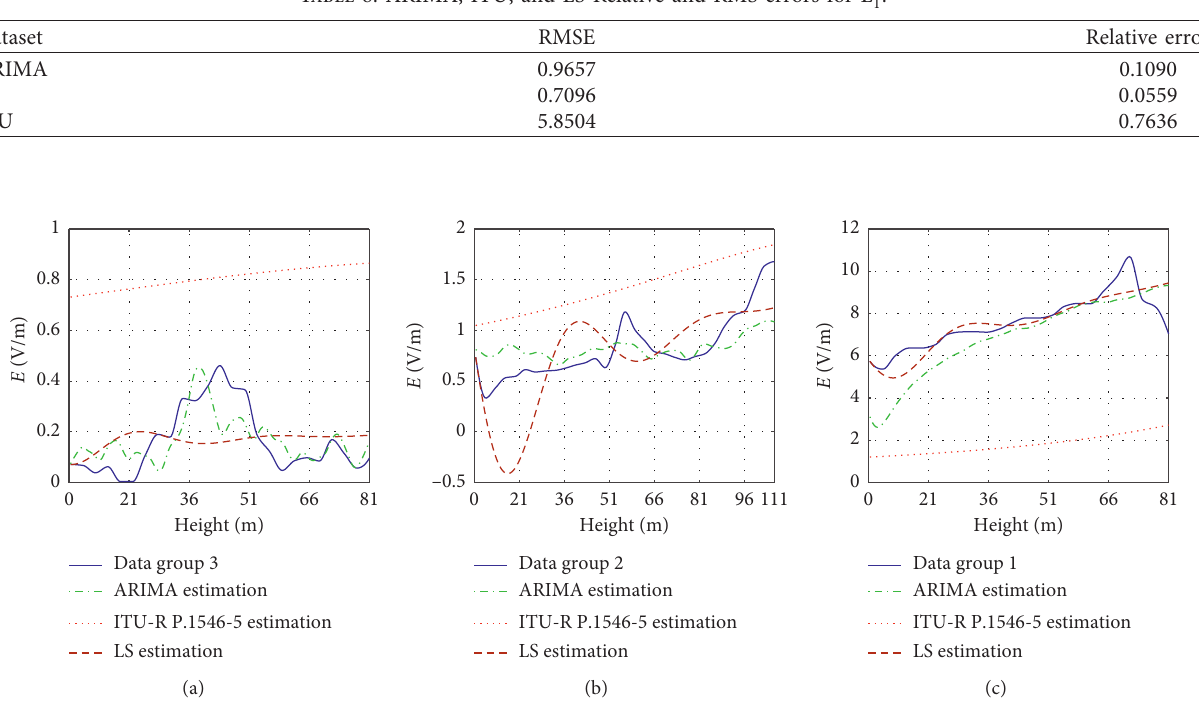
Table 8: ARIMA, ITU, and LS Relative and RMS errors for 􏽢 L